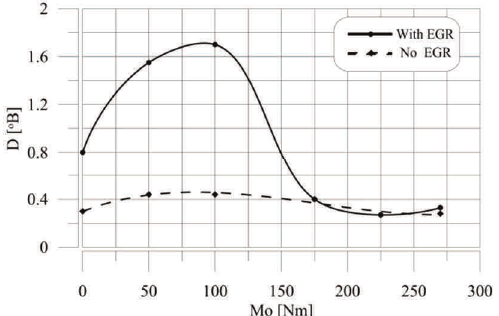
Fig. 18. Smoke exhaust D of diesel engine operating with/without EGR